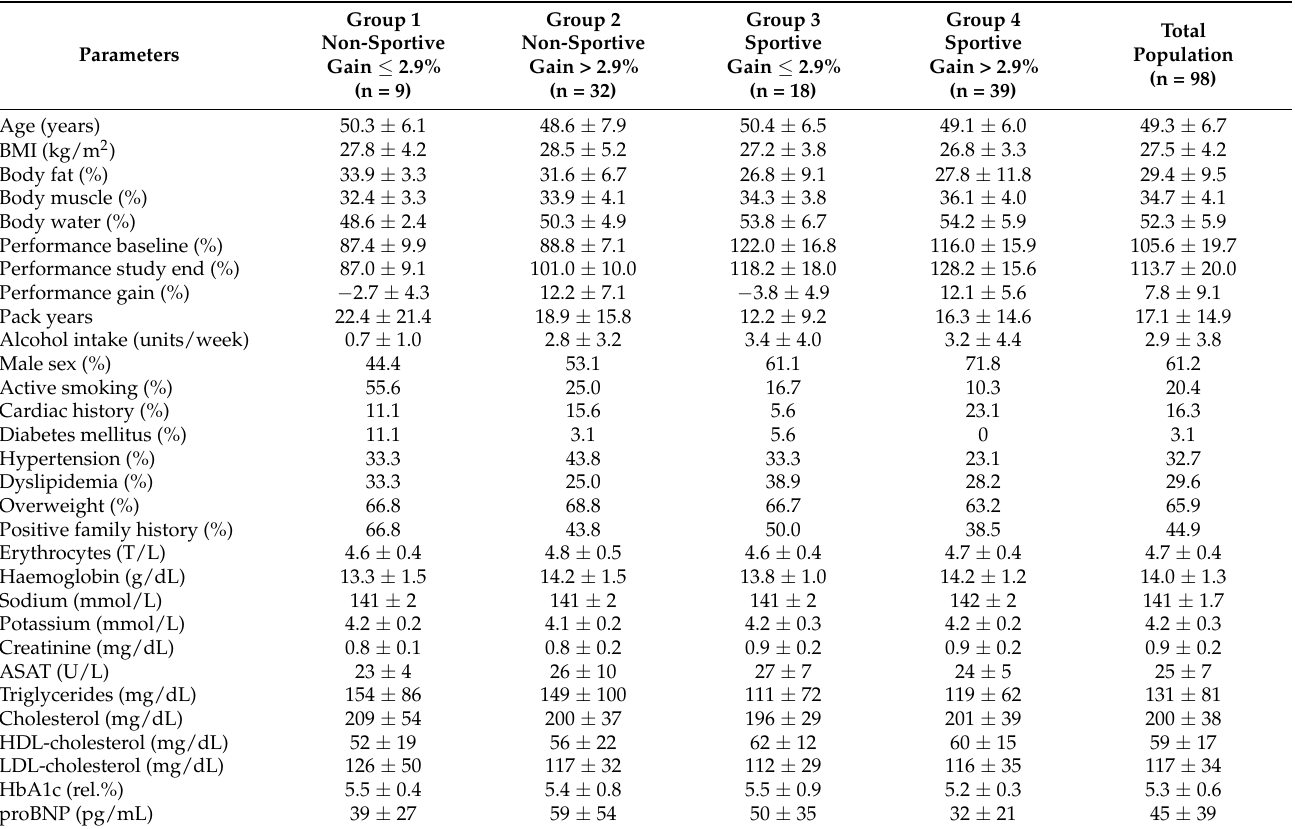
Table 1. Cardiovascular risk factor profile, anthropometric, and laboratory data at baseline of all four groups. Data are presented as mean ±